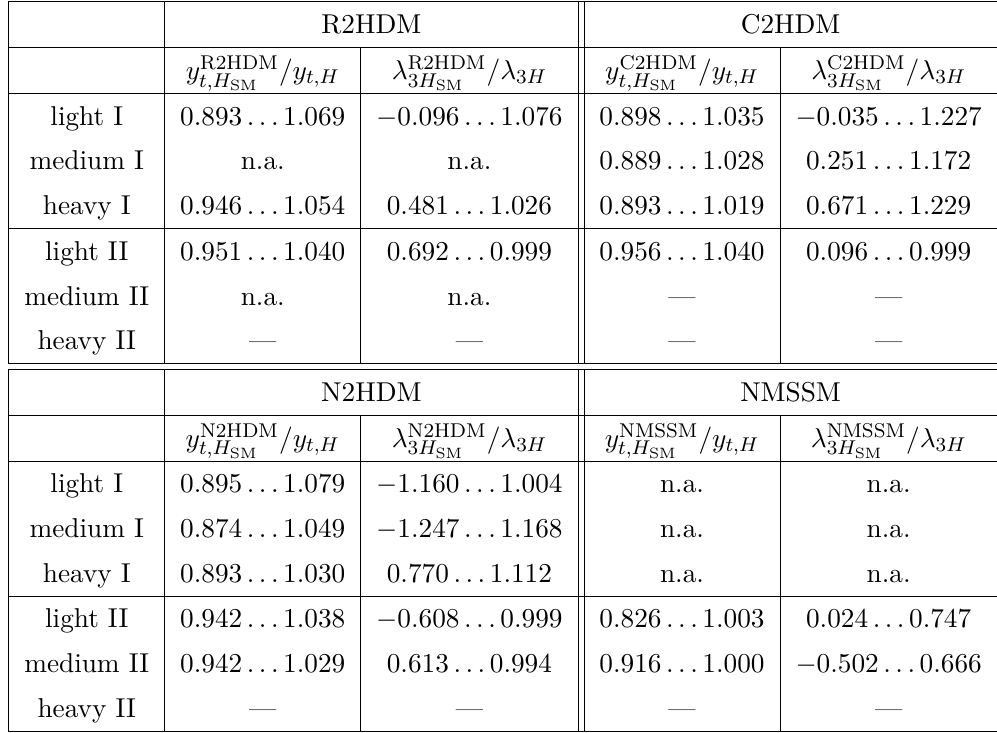
— — Table 5 . Allowed ranges for the top-Yukawa and trilinear Higgs self-coupling of the SM-like Higgs boson after application of all constraints, normalized to the corresponding SM value, for the R2HDM, C2HDM, N2HDM, and NMSSM, respectively, for type 1 (I) and type 2 (II). Light/medium/heavy correspond to H being the SM-like Higgs boson. The medium case is 1 / 2 / 3 not applicable (n.a.) to the R2HDM, type 1 is not applicable to the NMSSM. In our scans, for type 2 some of the cases were found not to be compatible with the constraints any more (marked by a dash in the